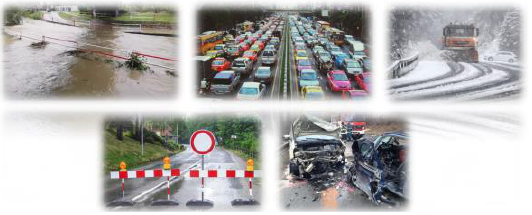
Figure 5. Uncertainty following randomly occurring failures in the network.